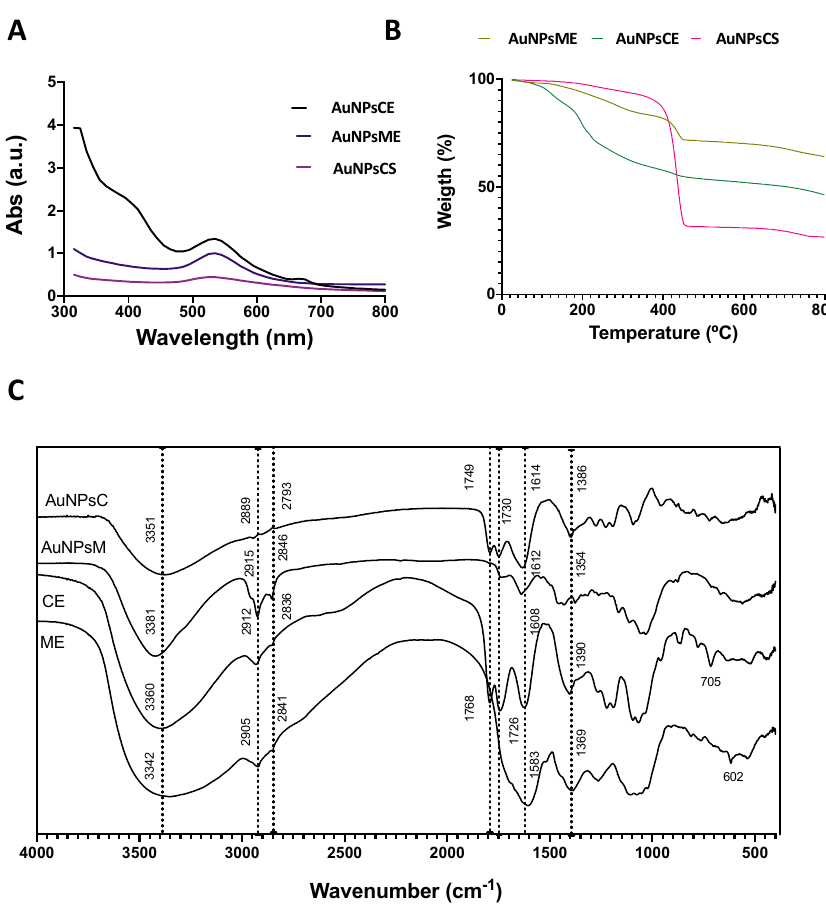
Figure 2. Synthesis and characterization of AuNPs. ( A ) Color change monitoring by UV-Vis spectra; ( B ) Thermogravimetric analysis (TGA) of AuNPs; ( C ) FT-IR spectra of the synthesized AuNPs. AuNPsCE: Gold nanoparticles synthesized with castor bean ( R. communis ) leaves extract; AuNPsCS: Gold nanoparticles produced by chemical synthesis; AuNPsME: Gold nanoparticles synthesized with common mullein ( V. thapsus ) flowers ethanolic extract; CE: Castor bean ( R. communis) leaves ethanolic extract; ME: Common mullein ( V. thapsus ) flowers ethanolic